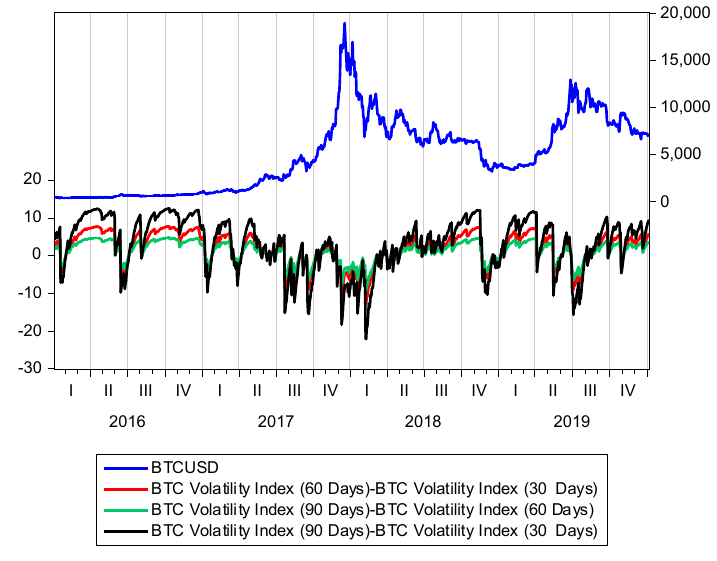
Figure 6. BTCUSD GARCH(1,1) Term structure.